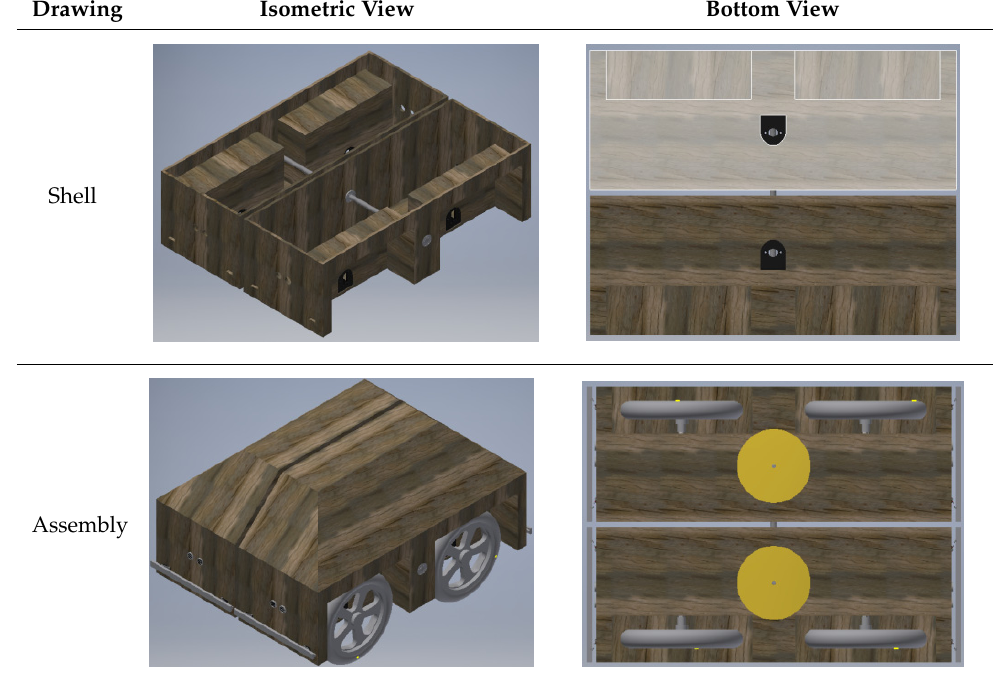
Figure 11. Hand-sketched drawing of the final concept. Table 19. Isometric and bottom view of the lawnmower (shell and assembly). Drawing Isometric View Bottom View